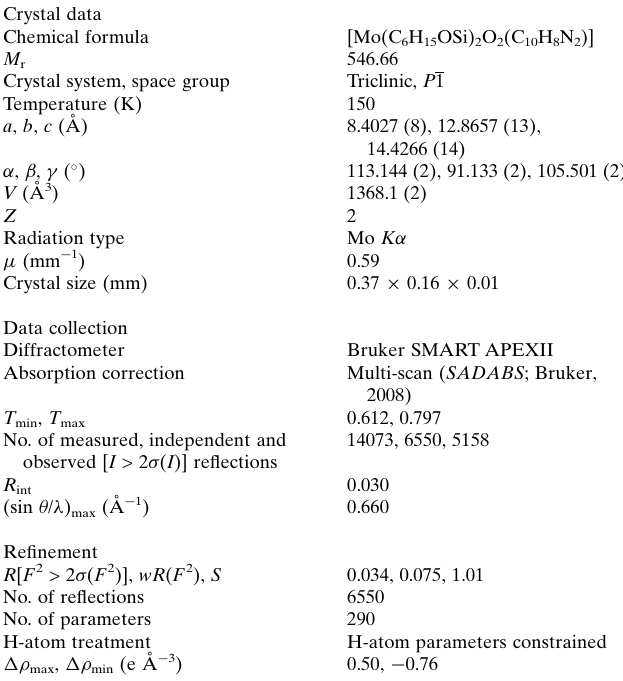
Table 3 Experimental details. Crystal data Chemical